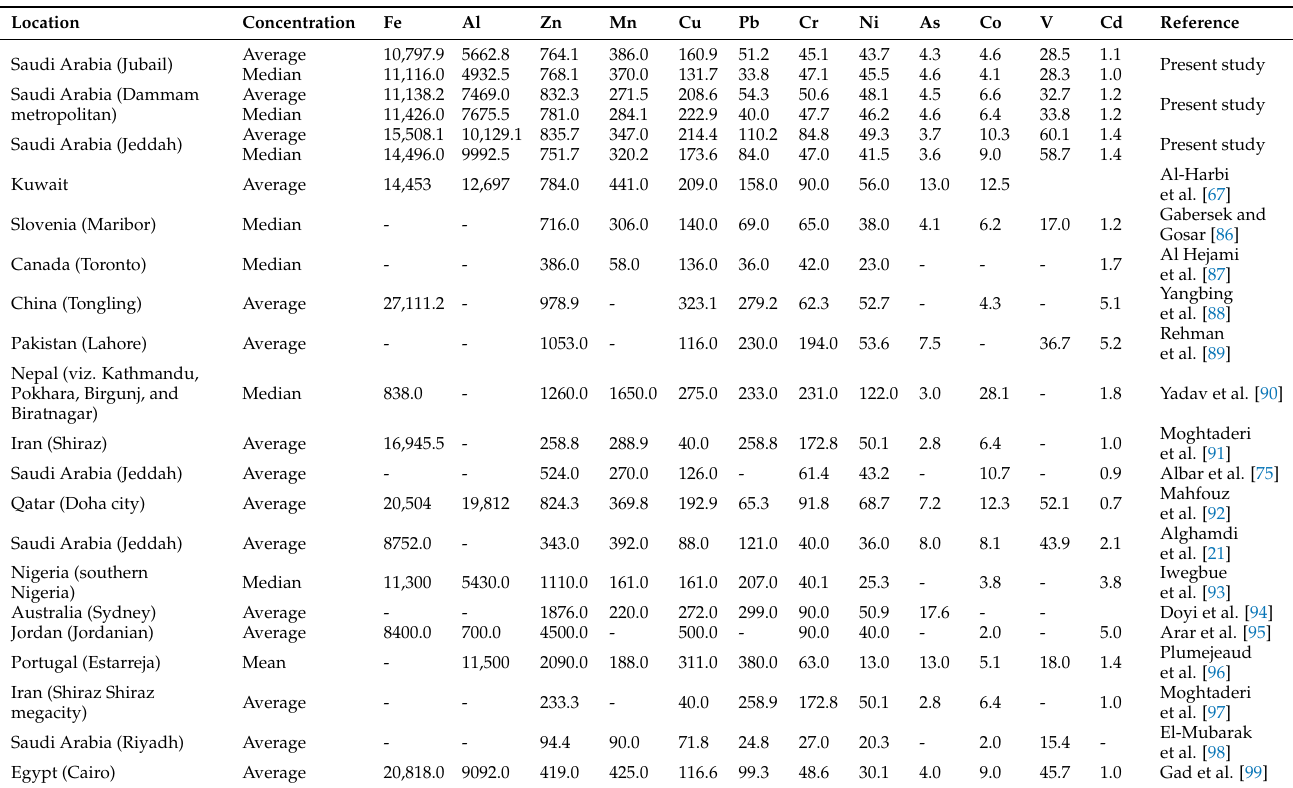
Table 2. Comparison of the PHEs concentrations (mg/kg) in the ACFD from mosques in Saudi Arabia with indoor dust from other different cities of the